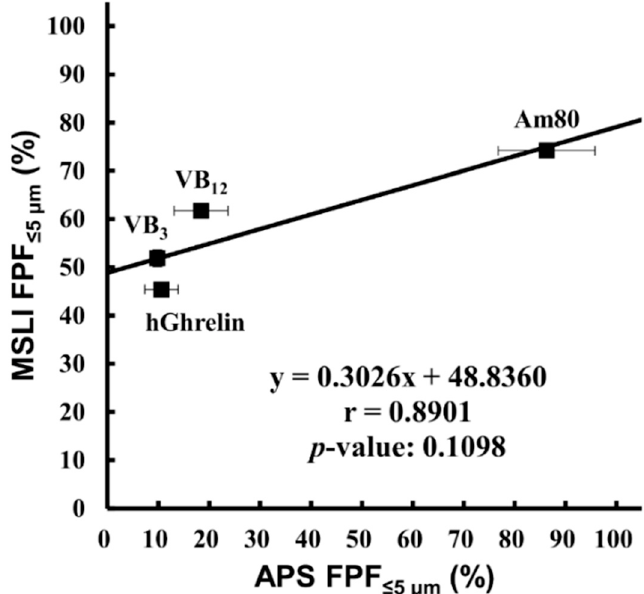
Figure 5. Correlation between MSLI FPF% ≤ 5 µ m and APS FPF% ≤ 5 µ m using the particle density calculated from MMAD and D 50 . Values of APS FPF% ≤ 5 µ m using the particle density described in Table 1 (mean ± S.E., n = 3) were plotted against values of MSLI FPF% ≤ 5 µ m (mean ± S.E., n = 3). MSLI, multi-stage liquid impinger; FPF, fine particle fraction; APS, aerodynamic particle sizer; MMAD, mass median aerodynamic diameter; hGhrelin, hGhrelin formulation containing 0.1 mg / vial of hGhrelin and 0.5 mg / vial of Phe; VB 3 , VB 3 formulation containing 0.1 mg / vial of VB 3 and 0.5 mg / vial of Phe; VB 12 , VB 12 formulation containing 0.1 mg / vial of VB 12 and 0.6 mg / vial of Phe; Am80, Am80 formulation containing 0.1 mg / vial of Am80 and 0.1 mg / vial of Phe.